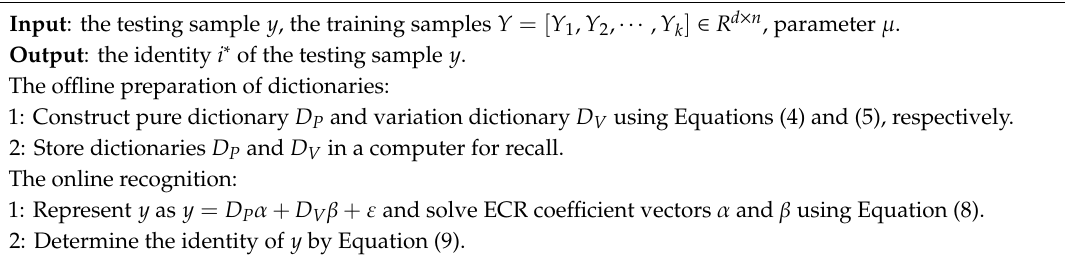
Algorithm 1. The ECR-based classification